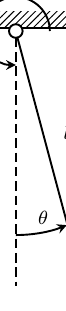
Figure 24. Simple pendulum.